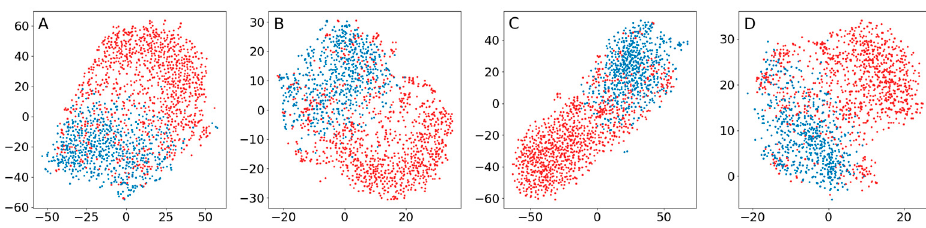
Figure A4. Comparison of parametric t-SNE and CNN encoders when using the normal and sug- gested distributions. Batch size during training with a batch size of 500 and perplexity/number of neighbors of 5. ( A ) Parametric t-SNE with a normal distribution and STFT features. ( B ) Parametric t-SNE with the suggested distribution and STFT features. ( C ) CNN encoder with a normal distribution. ( D ) CNN encoder with the suggested distribution.